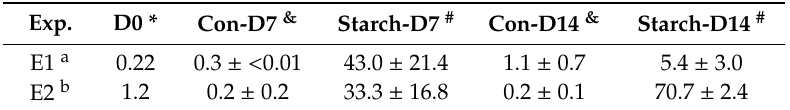
Table 2. Relative abundance of OTU Bt-00010 in rumen fluid inoculum samples (D0) and in batch cultures after an incubation period of 7 (D7) and 14 days (D14). Abundance is presented as a percentage (%) of the total number of non-chimeric reads per sample.